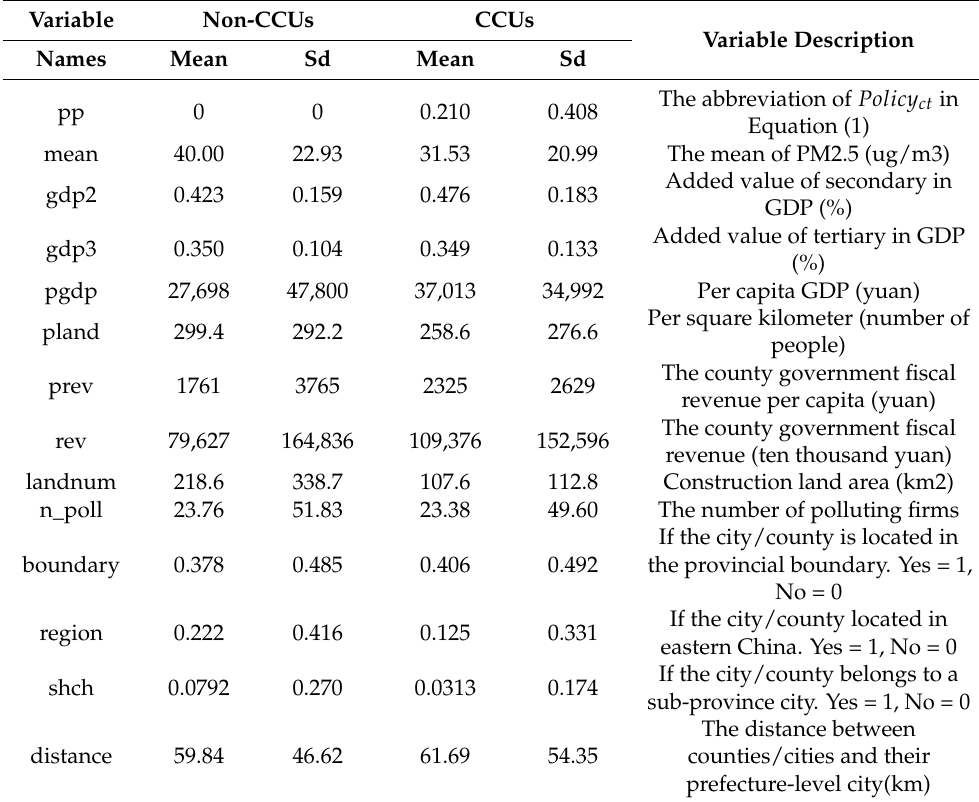
Table 2. Descriptive